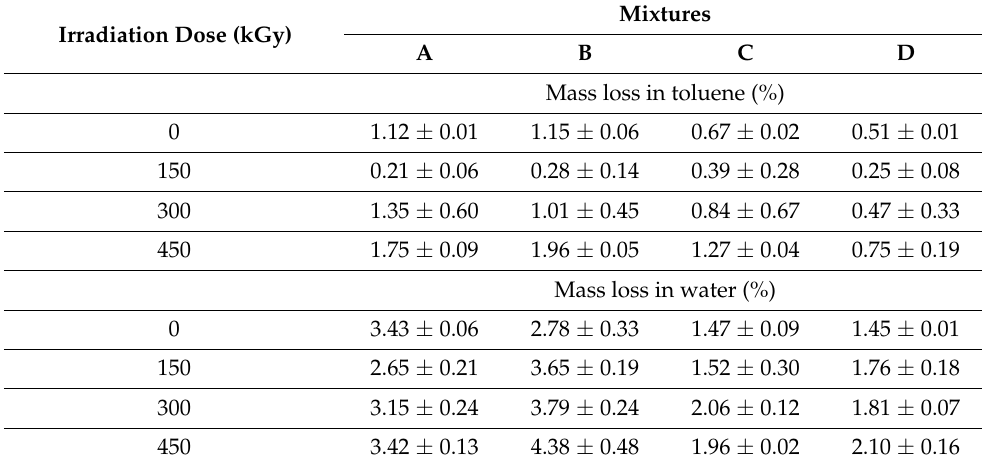
Table 7. Mass loss of the mixtures in toluene and